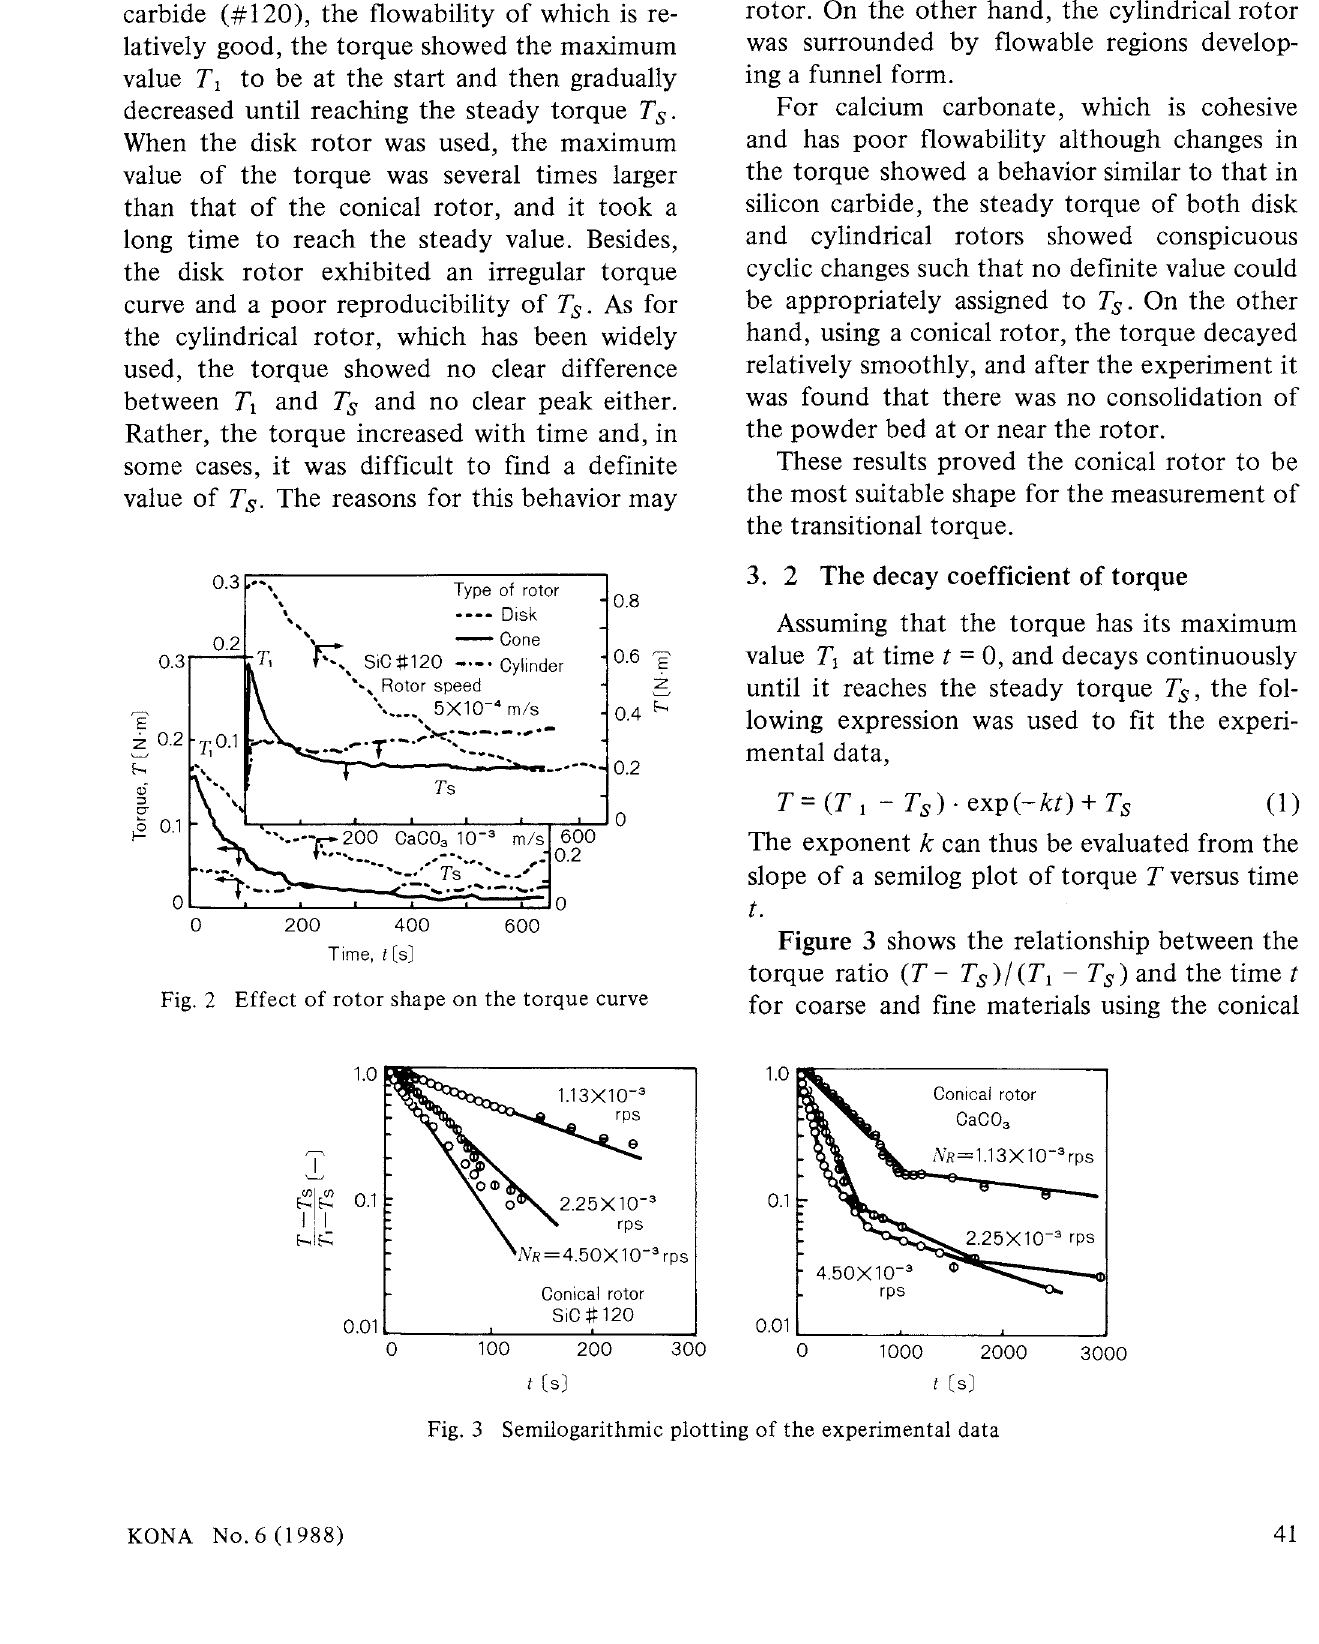
Fig. 3 Semilogarithmic plotting of the experimental